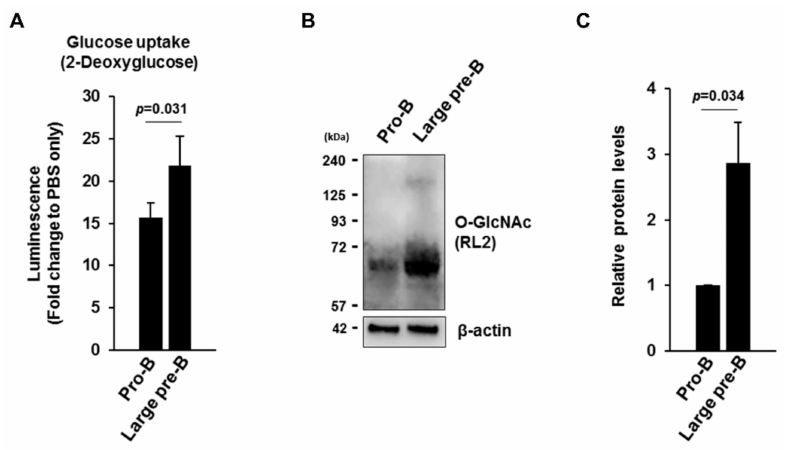
Figure 1. Glucose uptake and cellular O-GlcNAc levels are upregulated at the large pre-B cell stage relative to those in pro-B cells. ( A ) Glucose uptake assay using pro-B cells (B220 + IgM − CD43 + ) and large pre-B cells (B220 + Pre-BCR + ) sorted from mouse bone marrow (BM). Luminescence was measured as an indicator of the glucose consumption rate in 1 × 10 4 cells. Data are represented as mean ± SD ( n = 3) normalized using controls treated with PBS only without any cells. ( B ) Representative western blot showing bulk O-GlcNAcylation in pro-B cells and large pre-B cells. ( C ) Quantification of data from western blot results in ( B ). Data are represented as mean ± SD ( n = 3) normalized against β -actin, which was used as a loading control. ( A – C ) Pooled BM cells from eight or four mice for each experiment were used to isolate pro-B or large pre-B cells,